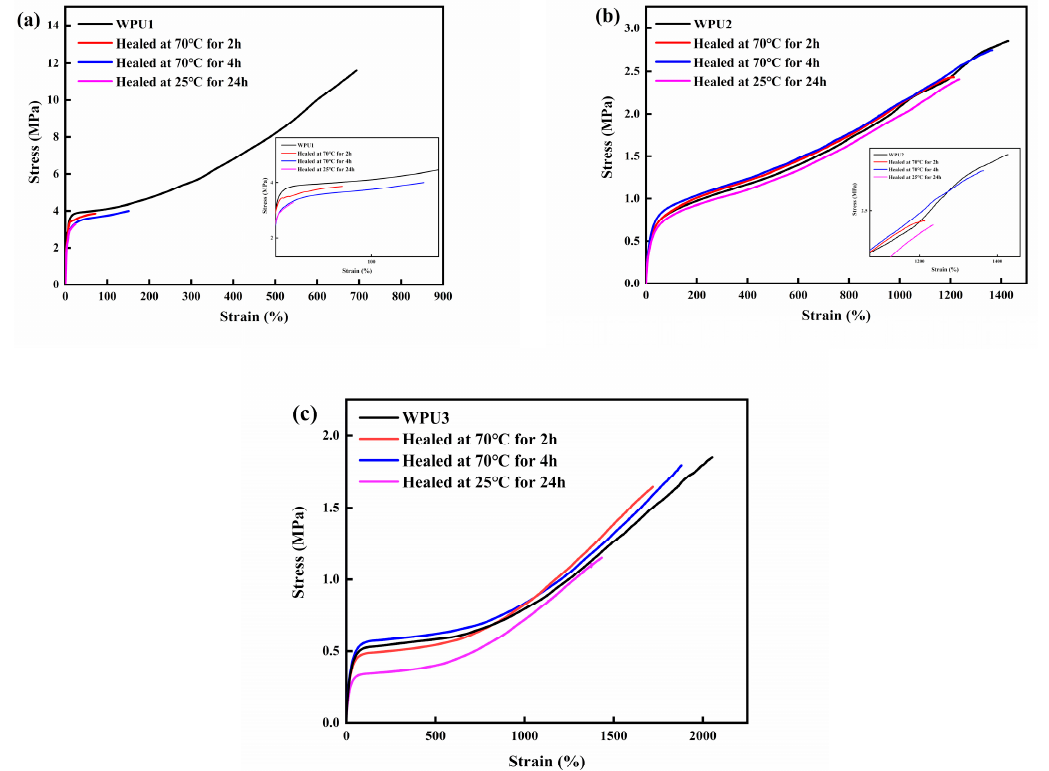
Figure 7. Stress-strain curves of WPU1 ( a ), WPU2 ( b ) and WPU3 ( c ) films repaired under different conditions.